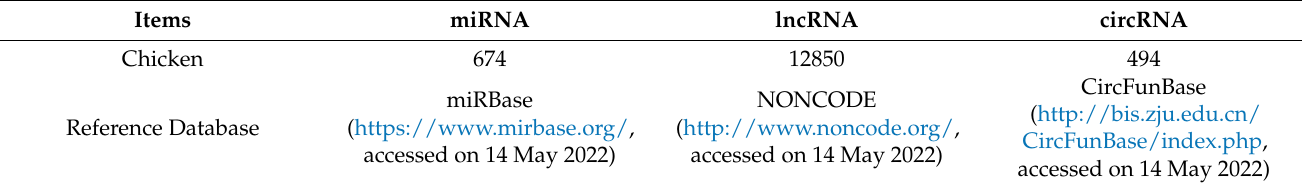
Table 1. Numbers of ncRNAs in domestic